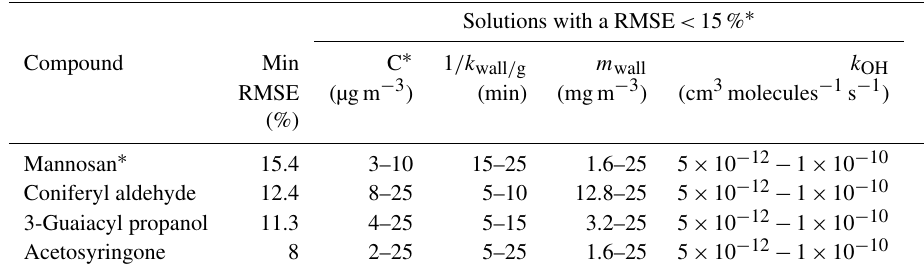
Table 4. Performance of the model for BBOA markers (iteration 4). Initial conditions for this run are presented in Table 2. The accommoda- tion coefficient was set at 0.1.